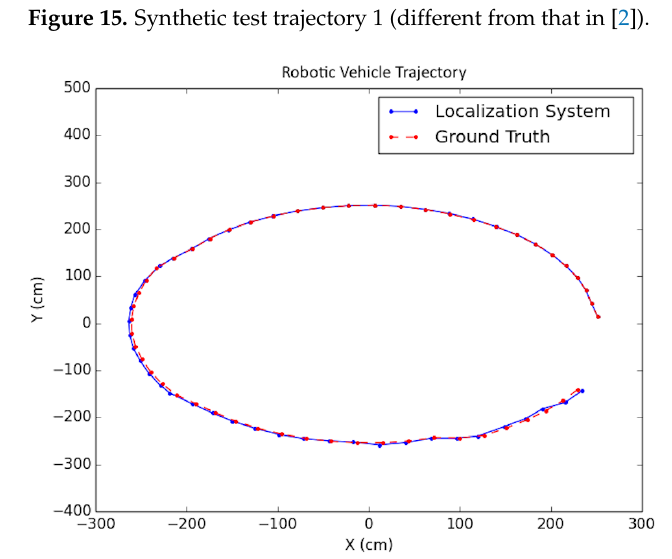
Figure 16. Synthetic test trajectory 2 (different from that in